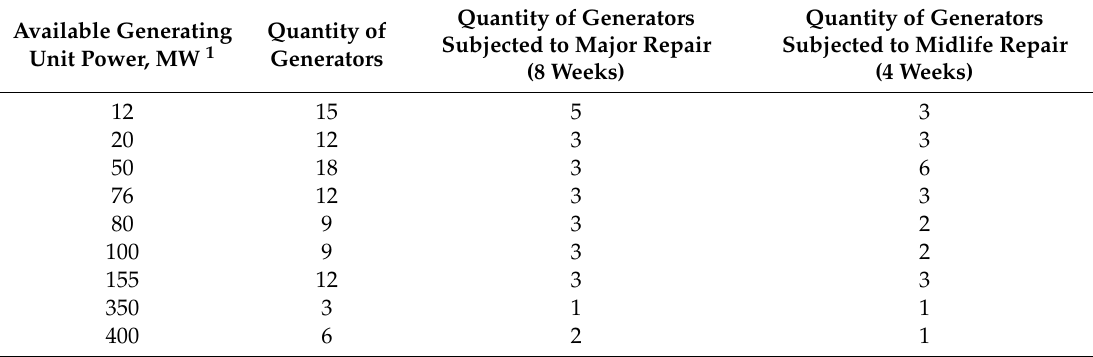
Table 3. The generation profile of the third test system and quantity of generators subjected to major and midlife